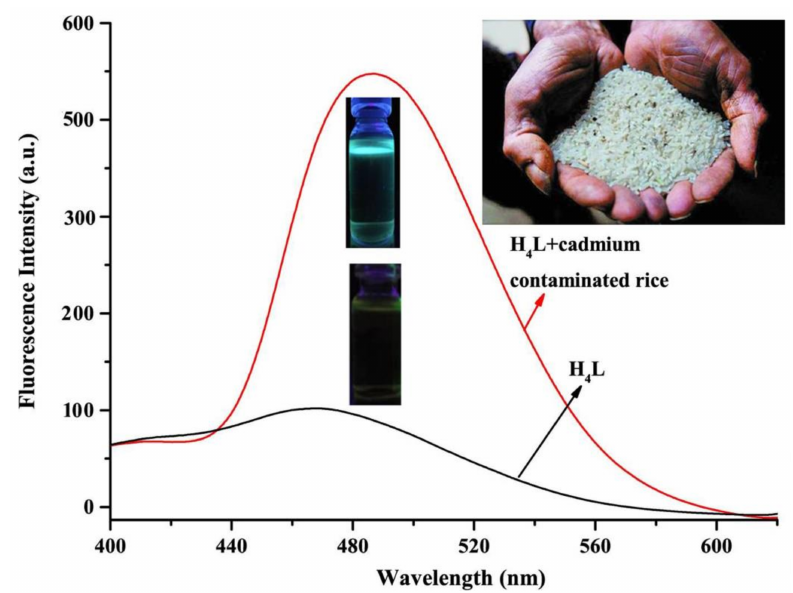
Figure 11. Fluorescence spectral response of sensor H 4 L in cadmium contaminated rice.